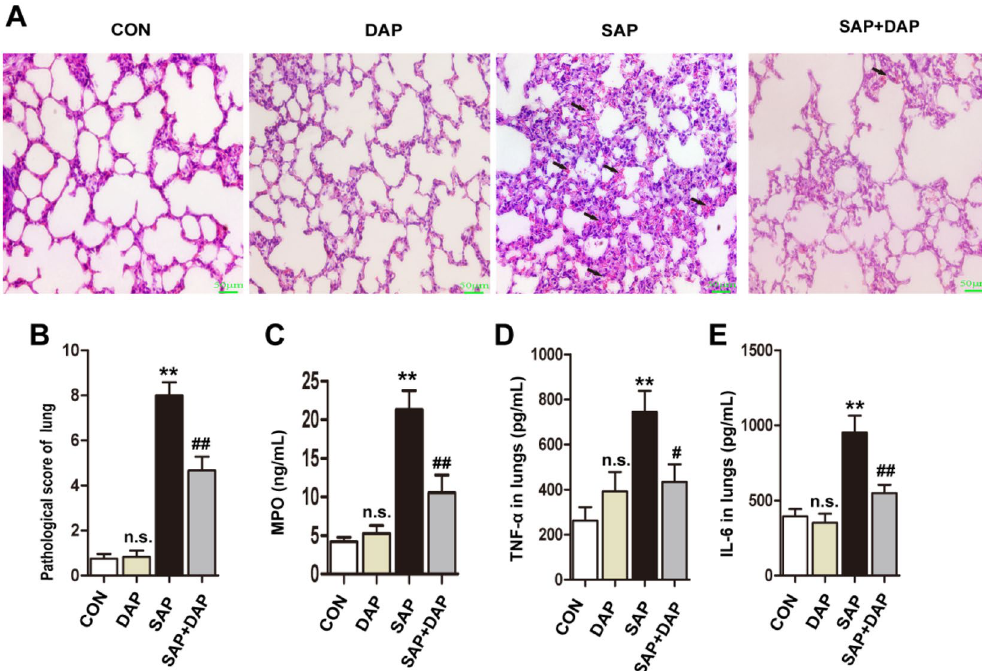
Figure 2. Daphnetin reduces lung damage and inflammation in mice with PALI. ( A ) Hematoxylin and eosin staining of the pancreas tissue, the magnification of each histological images were × 200. Arrows show alveolar thickening and inflammatory cell infiltration in lungs. ( B ) Scoring of alveolar septal capillary density in lung issues. Indicators of inflammation in lung tissue were detected by ELISA kits. The level of MPO ( C ) and TNF-α ( D ) and IL-6 ( E ) were reduced significantly after the pretreatment of daphnetin.The histograms were created using GraphPad 5 software(GraphPad Prism 5.01 http:// www. xdowns. com/ soft/ xdown s2009. asp? softid= 49668 & downid= 60& id= 52443). CON group, l-arginine vehicle + daphnetin vehicle; SAP group, l-arginine + daphnetin vehicle; DAP group, l-arginine vehicle + daphnetin; SAP + DAP group, l-arginine + daphnetin. Data are presented as the mean ± SD. n = 6 /group. ** P < 0.01 versus CON group. # P < 0.05 versus SAP group; ## P < 0.01 versus SAP group, n.s. P > 0.05 versus CON group. Scale bars: 50